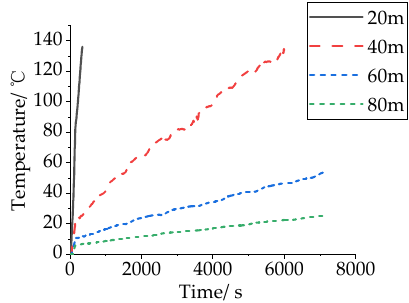
Figure 21. Center weld-joint temperature of different models.